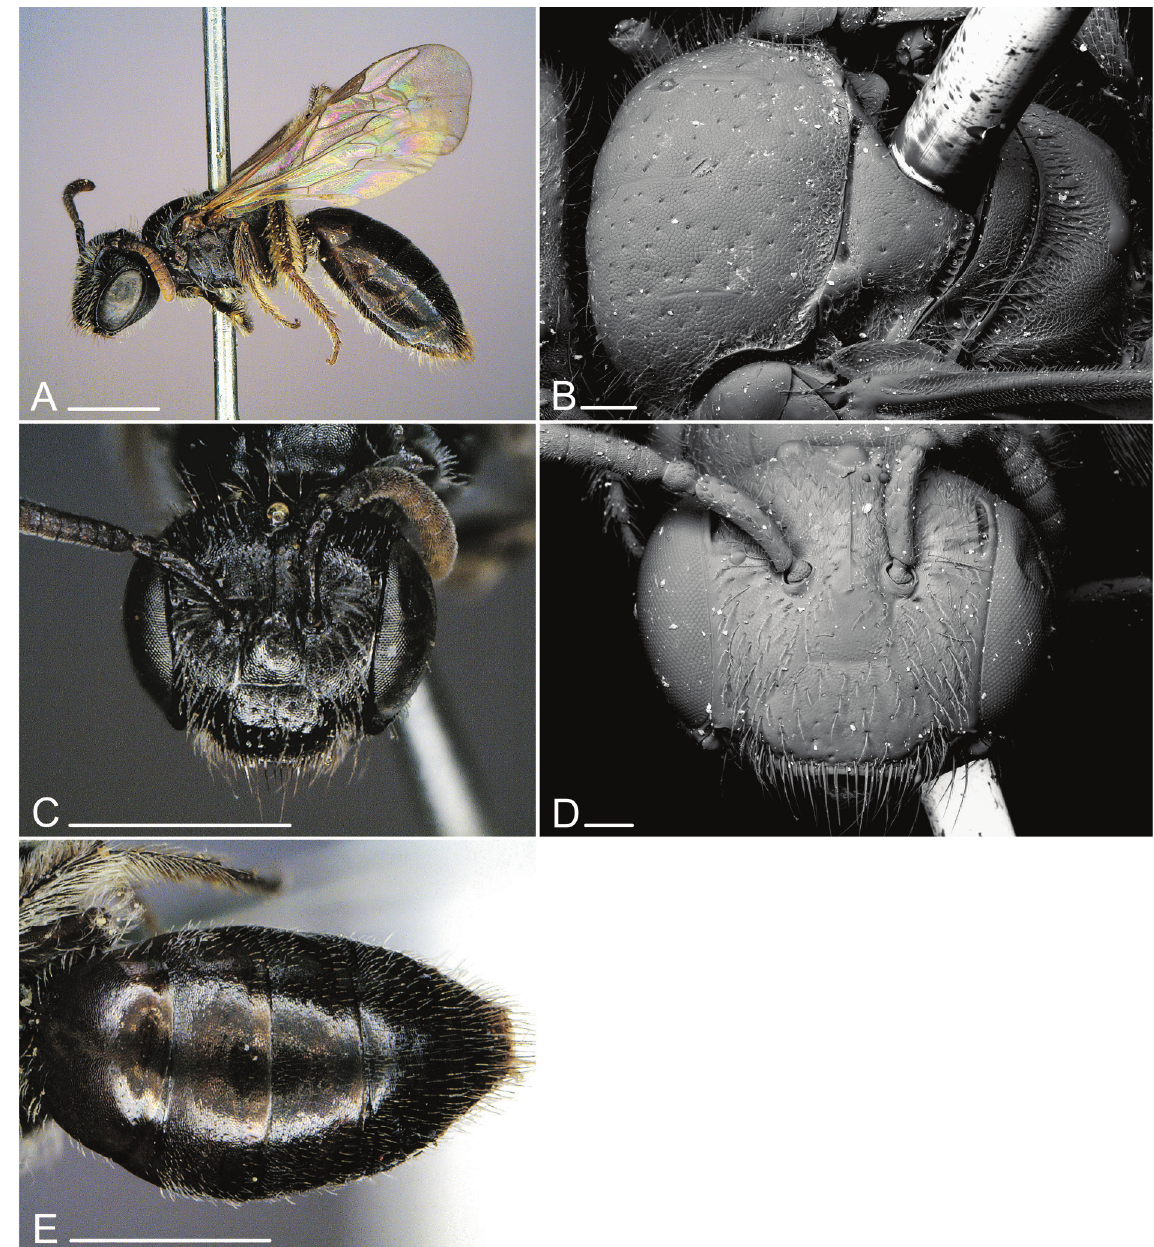
Fig. 19. Scrapter nigritarsis sp. nov., ♀. A . Lateral view. B . Thorax (dorsal view, SEM). C . Head. D . Head (SEM). E . Metasoma (dorsal view). Scale bars: photos: 1 mm, SEM: 0.1